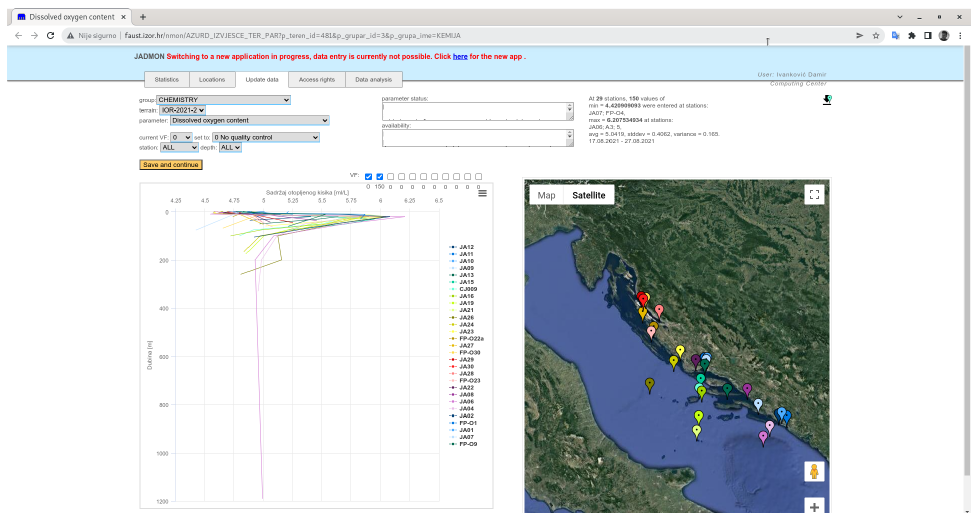
Figure 6. Screen shoot of the first version of web